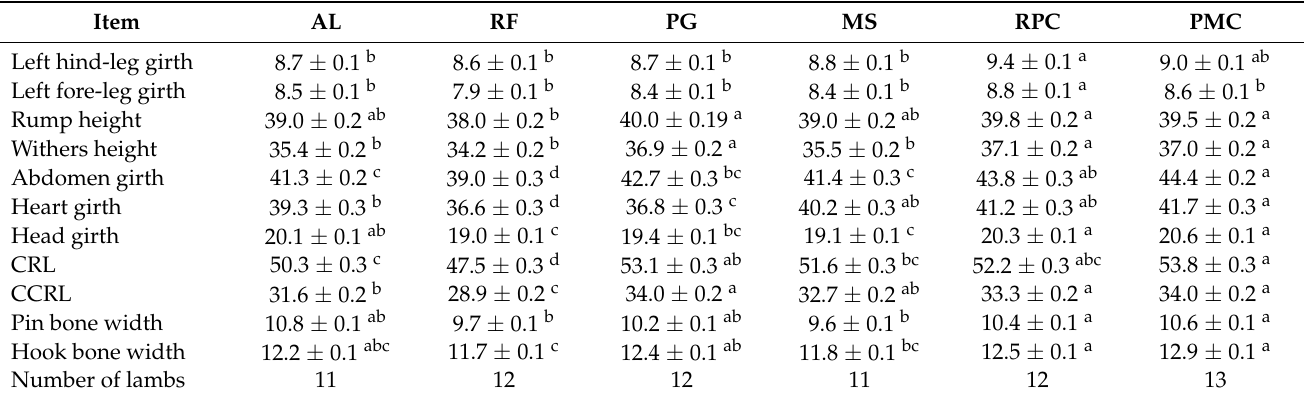
Table 3. Effect of feed restriction and supplementation with the 3 compounds propylene glycol, monensin sodium, and rumen-protected choline chloride in late pregnancy on lambs’ measurements (cm) at